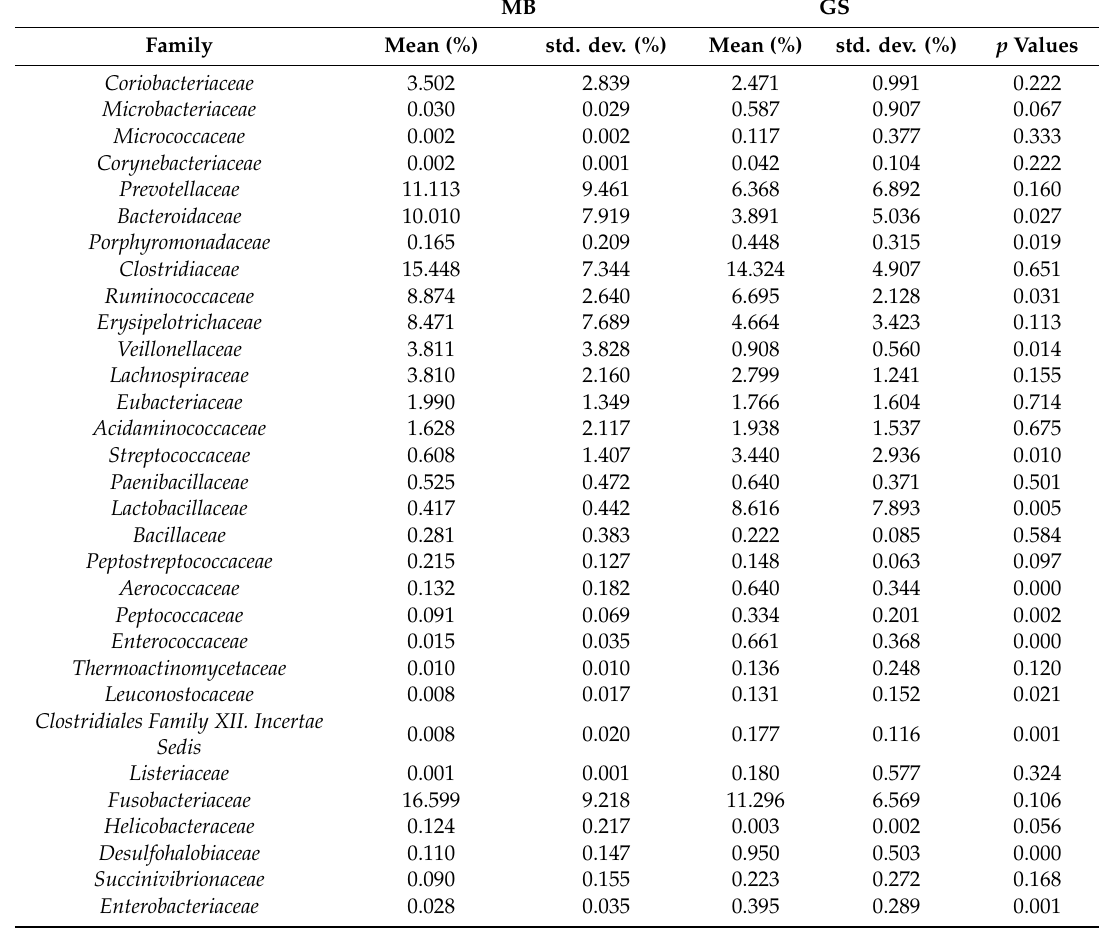
Table 4. Mean relative frequency of abundance (%) and corresponding standard deviation (SD) (%) of the families identified in the caeca of mixed breeds (MB) and German Shepherd (GS) dogs. The species indicated are those showing a mean relative frequency of abundance ≥ 0.1% in at least one group. p values in bold are those who are significantly di ff